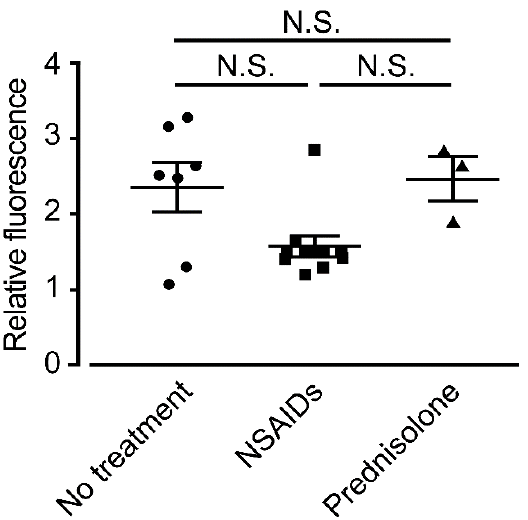
Figure A2. Fluorescence intensity in the no treatment group ( n = 7), NSAIDs ( n = 11), and presnisolone ( n = 3). Fluorescence intensity is expressed as a ratio of the amount of fluorescence in the 5-ALA supplemented group relative to the amount of fluorescence in the vehicle group for each sample. The horizonal lines indicate the mean ± SD.